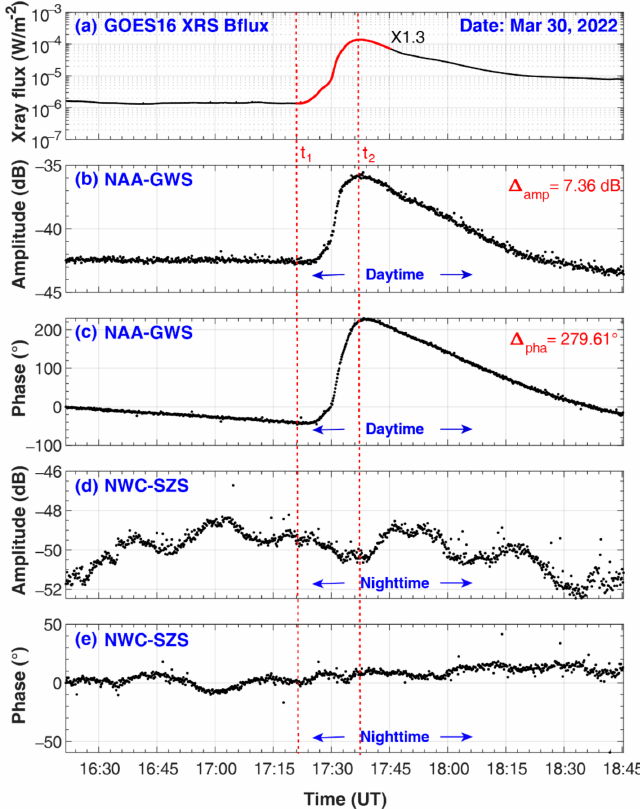
Figure 2. Responses of VLF signals to the X1.3 solar flare event on 30 March 2022, ( a ) the variation of X-ray flux, ( b , c ) the amplitude and phase of NAA signals observed at the GWS station, and ( d , e ) the amplitude and phase of NWC signals observed at the SZS